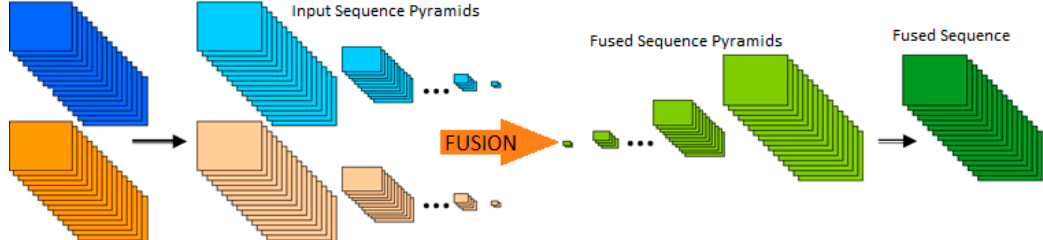
Figure 1. 3D Gaussian pyramid decomposition.